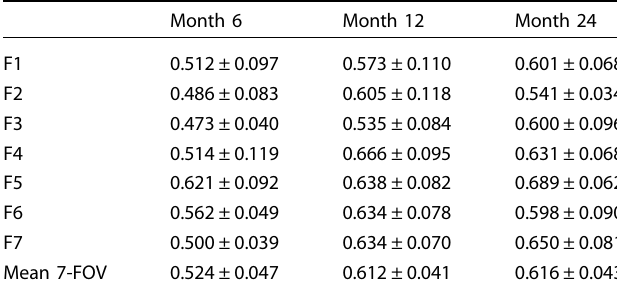
Table 1. Mean AUC and standard deviation of the individual FOV- speci fi c CNNs computed over the 5 hold-out sets ( fi rst 7 rows) and corresponding pooled mean and standard deviation (last